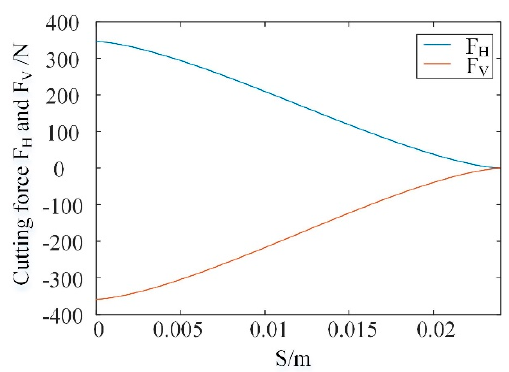
Figure 14. The 60 ◦ rake angle of the blade corresponded to the cutting force F H and F V. Figure 14. The 60° rake angle of the blade corresponded to the cutting force F H and F V.